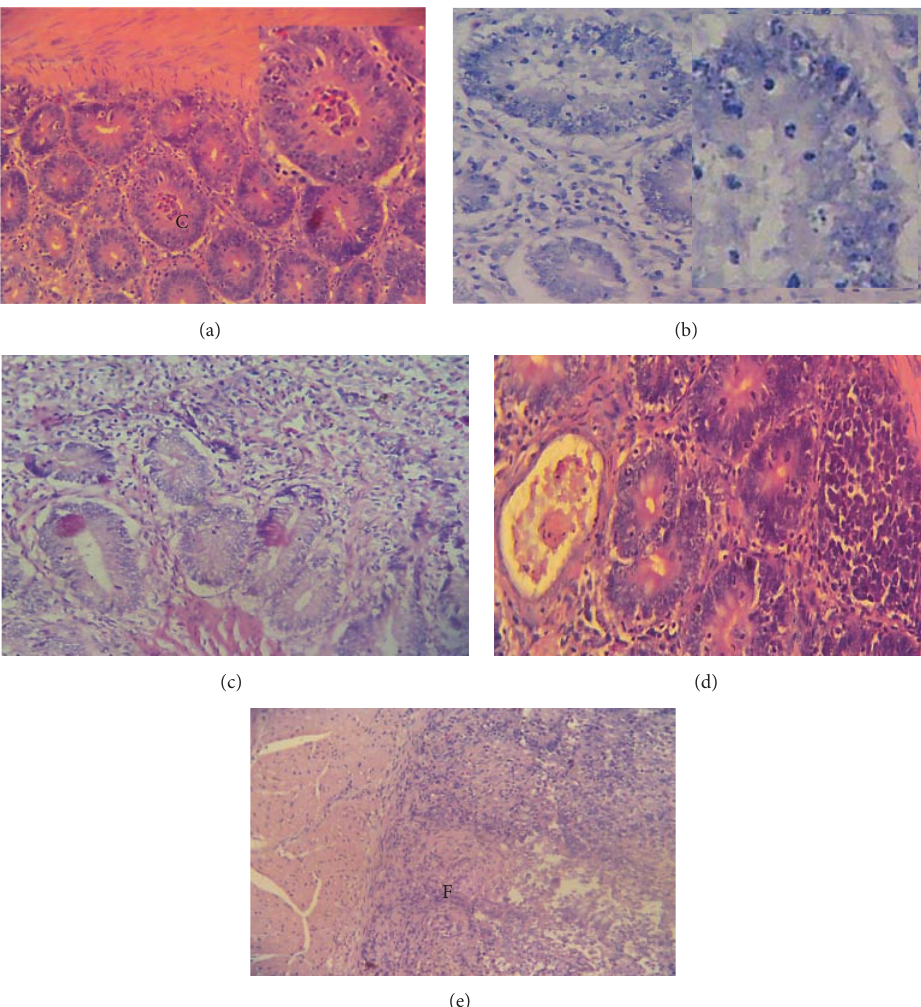
Figure 7: Photomicrograph of the intestine of chickens infected with Eimeria oocysts and treated with graded doses of the combined extract and control. (a) 100 mg/kg: combined extract of KS and AI treatment; moderate cryptic destruction and intracryptic developmental stages of Eimeria H&E: × 400. (b) 200 mg/kg: intestine infected with Eimeria spp.; moderate cryptic destruction and intracryptic developmental stages of Eimeria and intestinal fibrosis H&E: × 400. (c) Amprolium 10mg/L: chicken, intestine, moderate cryptic destruction and ectasia, intracryptic developmental stages of Eimeria , and intestinal fibrosis H&E: × 400. (d) 400 mg/kg extract: moderate cryptic destruction and intracryptic developmental stages of Eimeria H&E: × : 400. (e) Control ( − ve) intestine infected with Eimeria spp.; severe cryptic destruction and intracryptic developmental stages of Eimeria and intestinal fibrosis H&E: × 400.